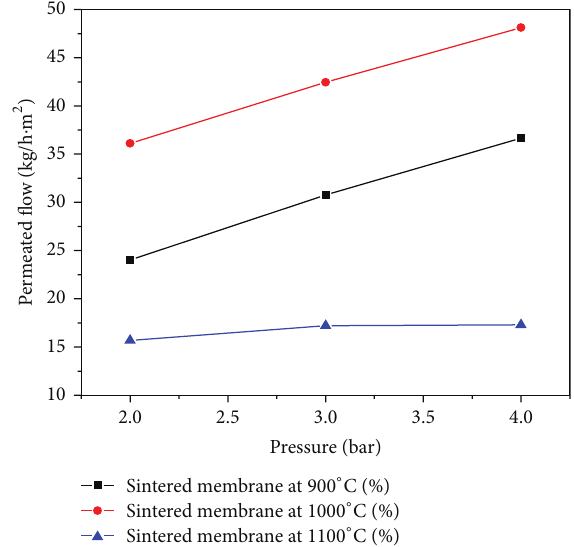
Figure 6: Water permeated flow versus applied pressure for the membrane sintered at 900, 1000, and 1100 ∘